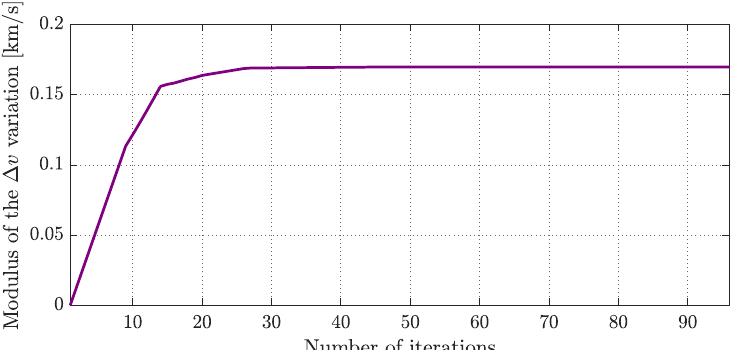
Figure 9. Evolution of the magnitude of the ∆ v , in km/s, relative to the initial velocity of propagation, during the iterative process.